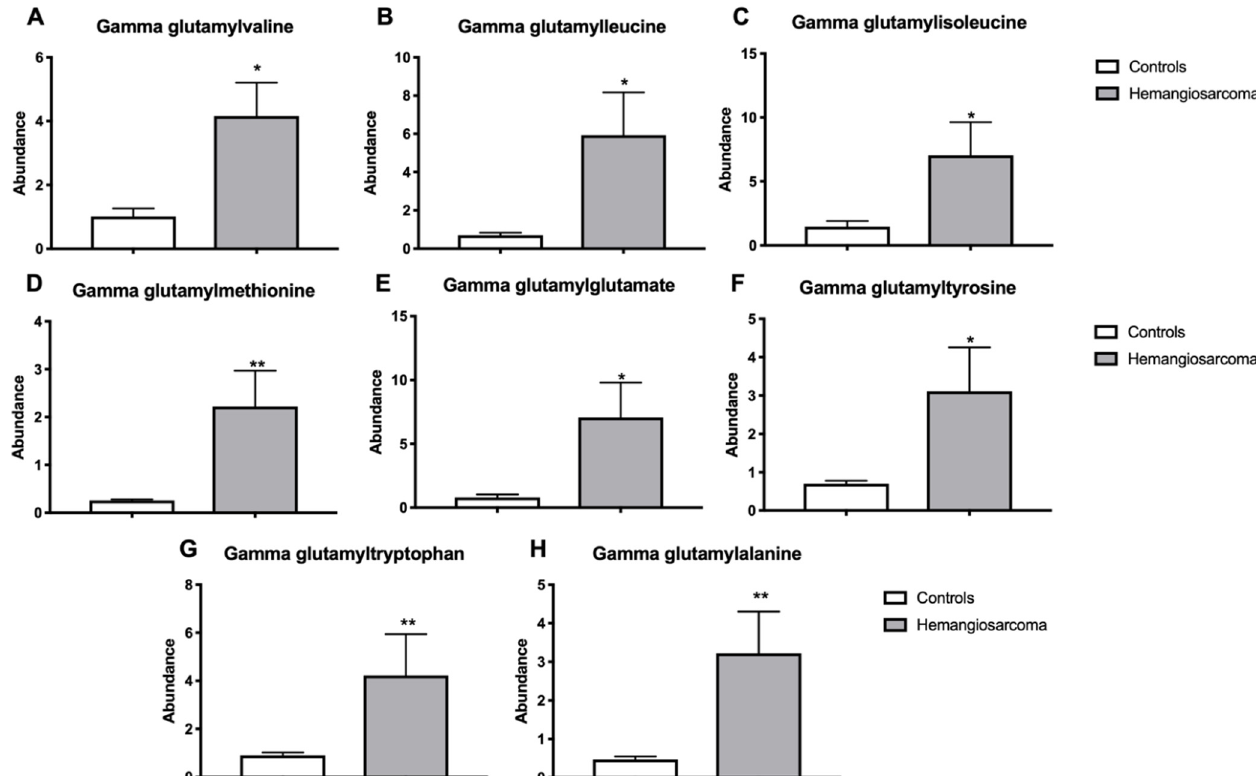
Figure 4. Serum gamma-glutamyl amino acids are increased in VC-mediated hemangiosarcoma. Serum gamma-glutamylvaline ( A ), gamma-glutamylleucine ( B ), gammaglutamylisoleucine ( C ), gamma-glutamylmethionine ( D ), gamma-glutamylglutamate ( E ), gamma-glutamyltyrosine ( F ), gamma-glutamyltryptophan ( G ) and gamma-glutamylalanine ( H ) are plotted for control group, Control and Hemangiosarcoma groups. Data are represented as mean ± SEM. * denotes significance with p < 0.05, ** p < 0.01.